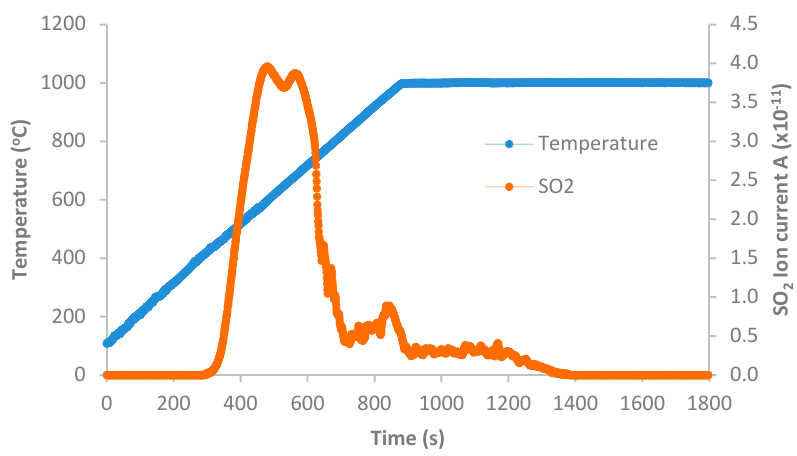
Figure 2. SO 2 ion current from QMS and temperature versus time for the ground chalcopyrite oxidation in simulate air (22.4 vol.% O 2 /Ar) at 1000 °C in a TGA-QMS.